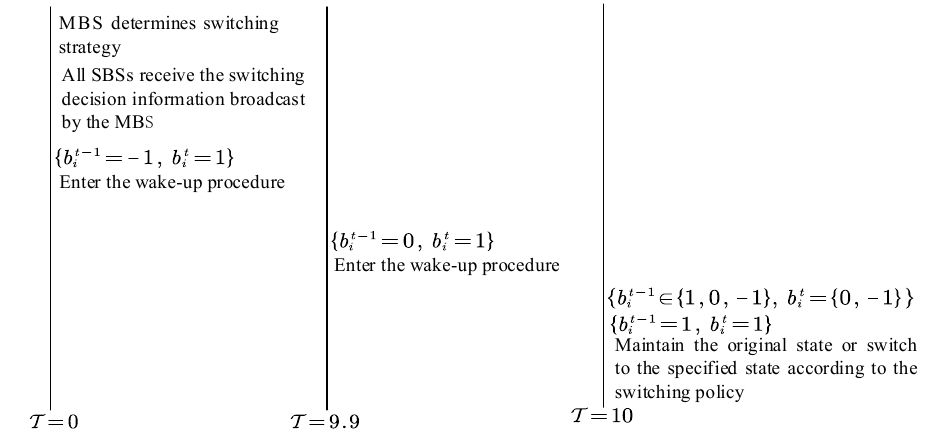
Figure 5. Asynchronous switching mechanism diagram.